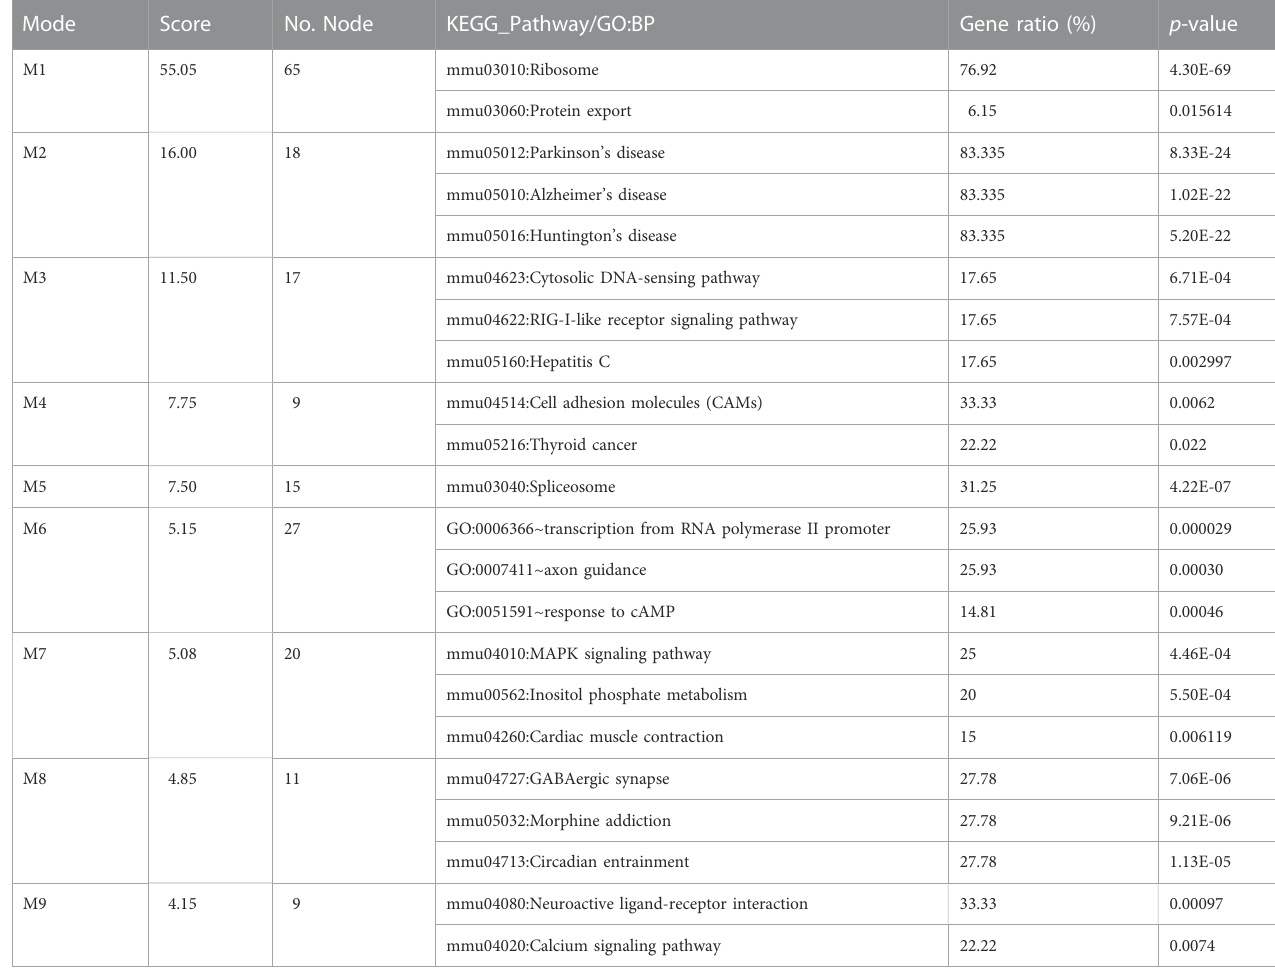
TABLE 1 GO and KEGG pathways enriched in each module.